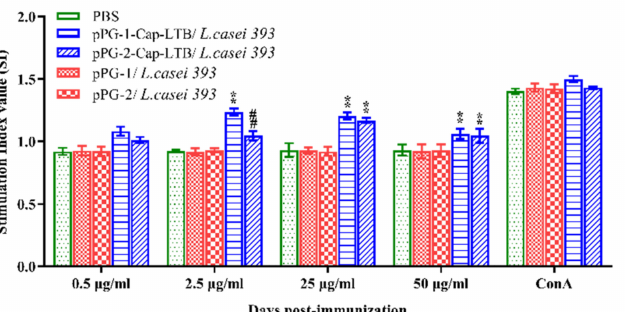
Figure 5. Lymphocyte proliferation in immunized mice detected by 3-(4,5-dimethylthiazol-2-yl)-2,5- diphenyltetrazolium bromide (MTT) assay in response to PCV2 Cap protein as a stimulating agent. Bars represent the mean ± standard error of each group (* p < 0.05, ** p < 0.01 compared to the control groups: pPG-1/ L. casei 393 and # p < 0.05, ## p < 0.01 compared to group: pPG-2/ L. casei 393